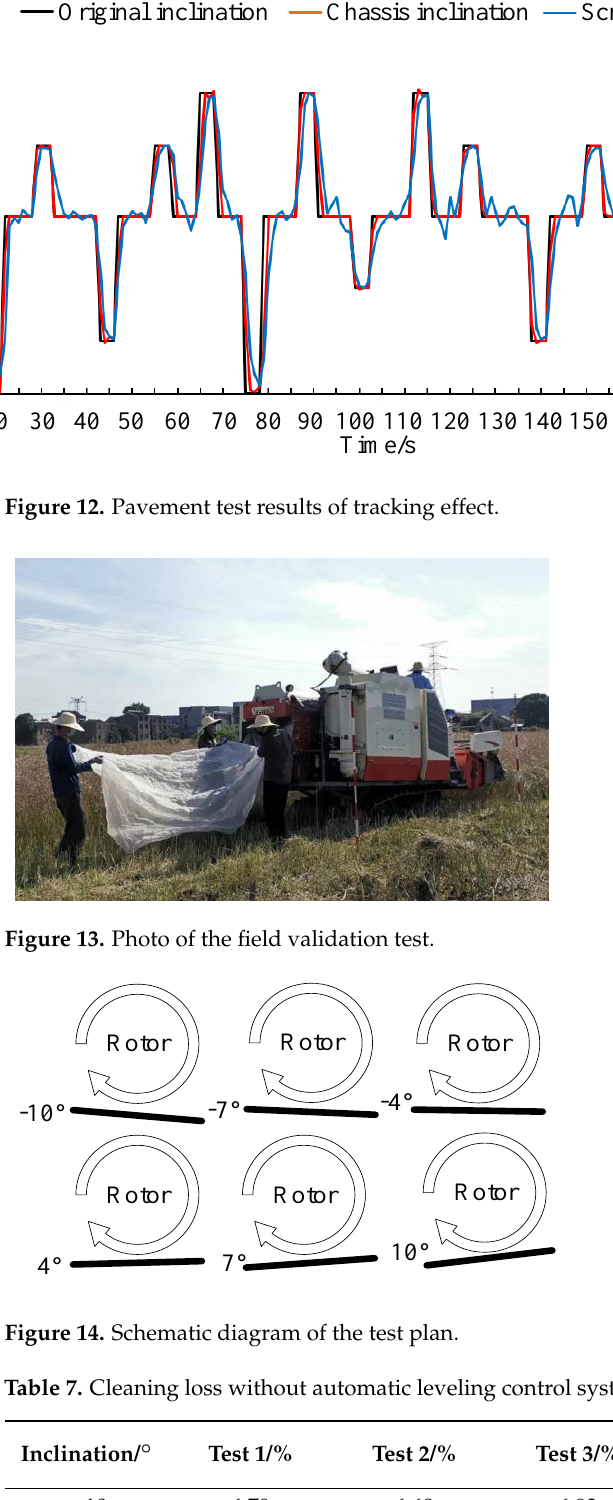
Figure 12. Pavement test results of tracking effect.